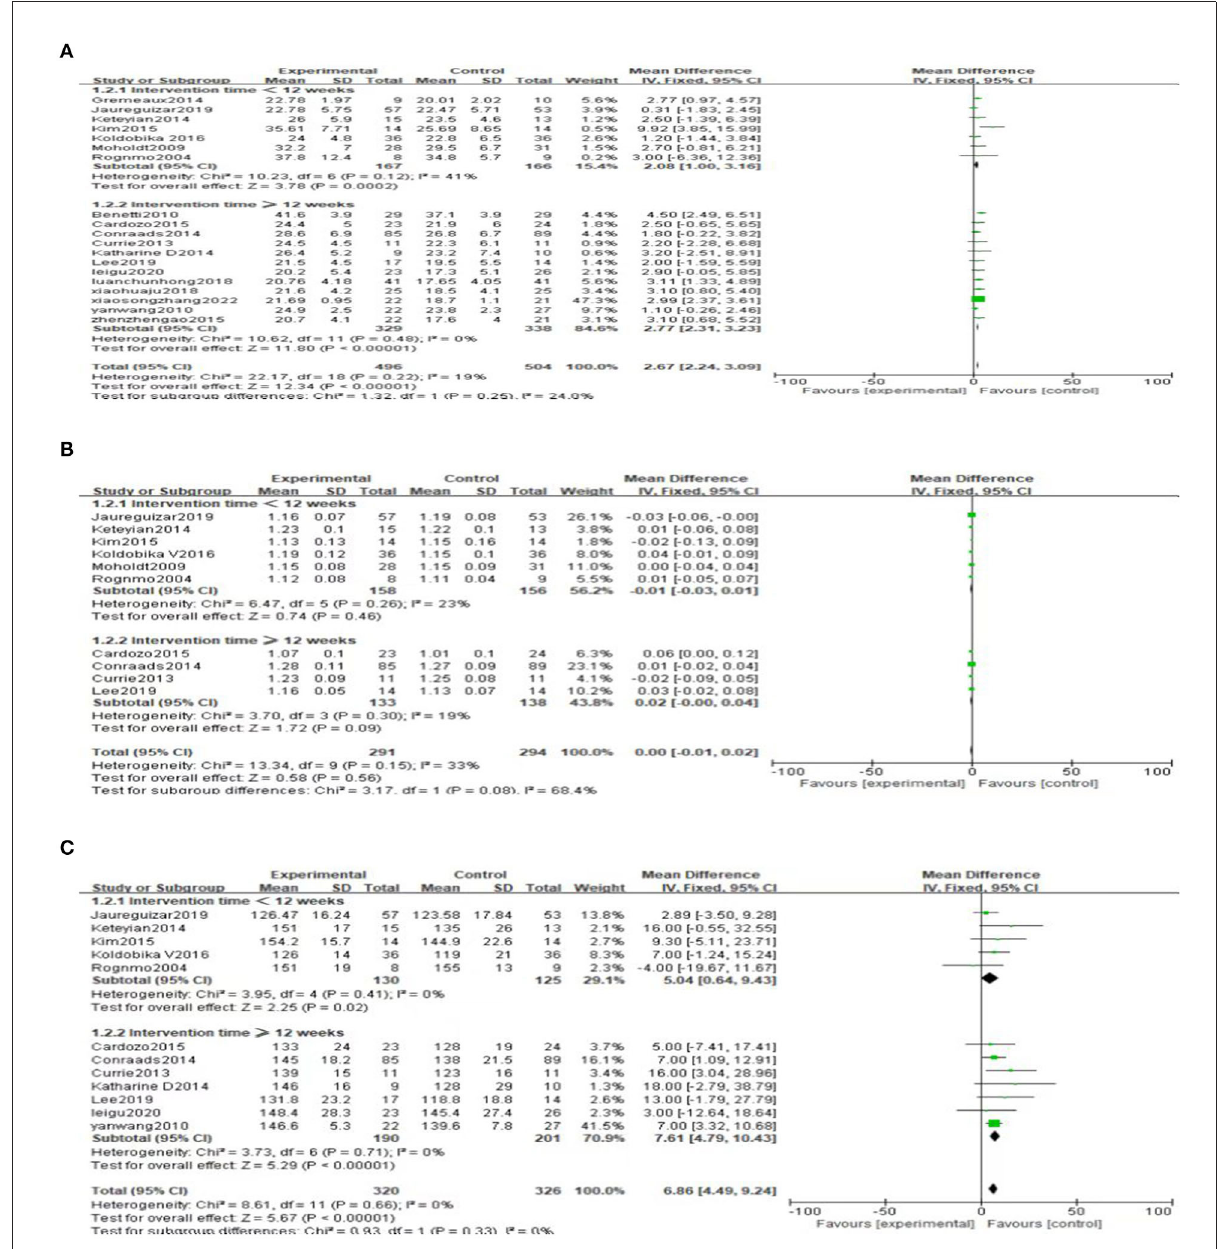
FIGURE10 (A) Subgroup analysis of peak VO 2 . (B) Subgroup analysis of RER. (C) Subgroup analysis of PHR.